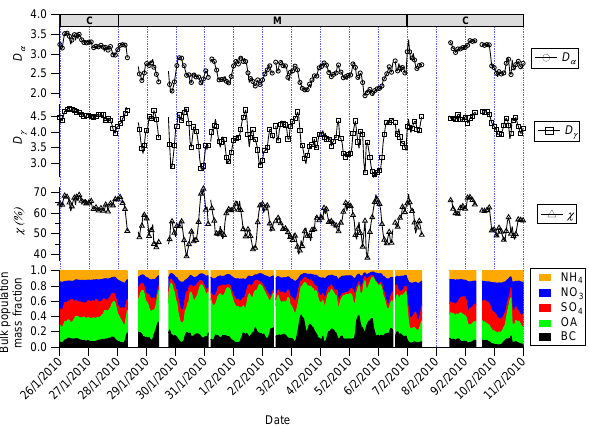
Figure 8. Temporal trends for average single particle diversity ( D α ) , average bulk population diversity ( D γ ) , mixing state ( χ) and average bulk population composition. “M” and “C” correspond to periods influenced by marine and continental air masses, respec- tively.